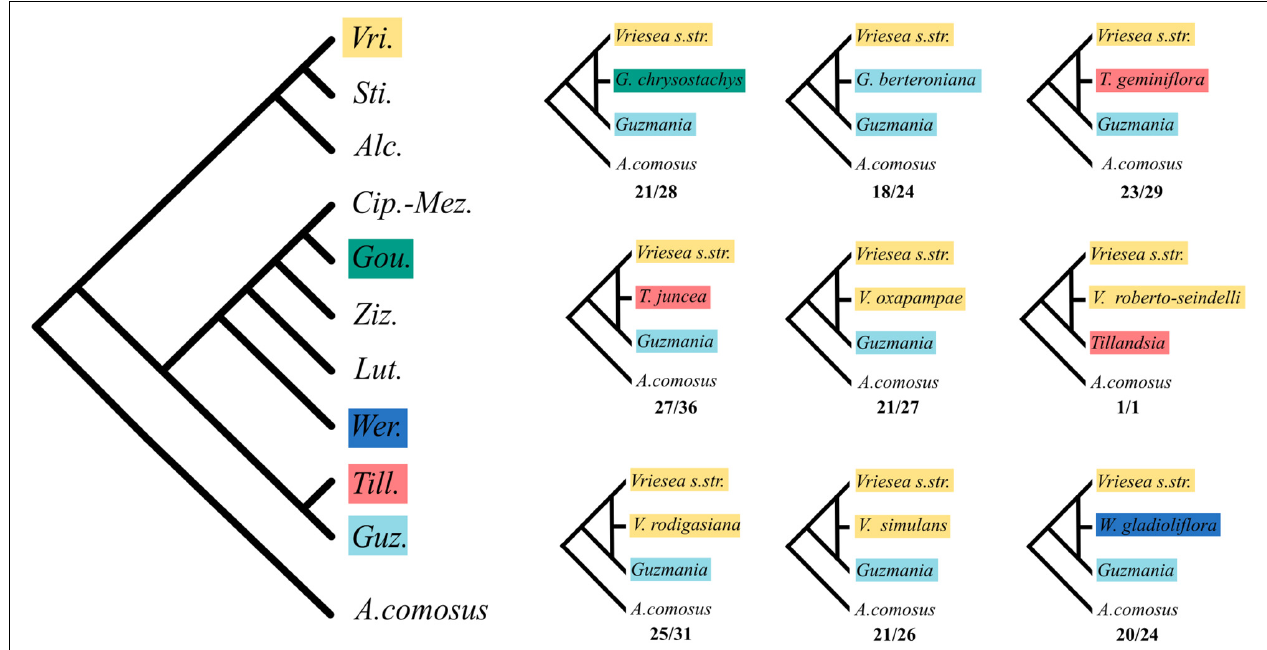
FIGURE 4 | Most likely ancestral intergeneric hybridization events detected by HyDe. Left: Cladogram of the intergeneric phylogenetic relationships within core Tillandsioideae. Colored squares show genera where hybrids have been detected. Right: Most frequent combinations for the generic origin of the nine inter-generic hybrids inferred by HyDe. Numbers below each quartet indicate the number of time the depicted combination was found over the total number of significant triplets for that